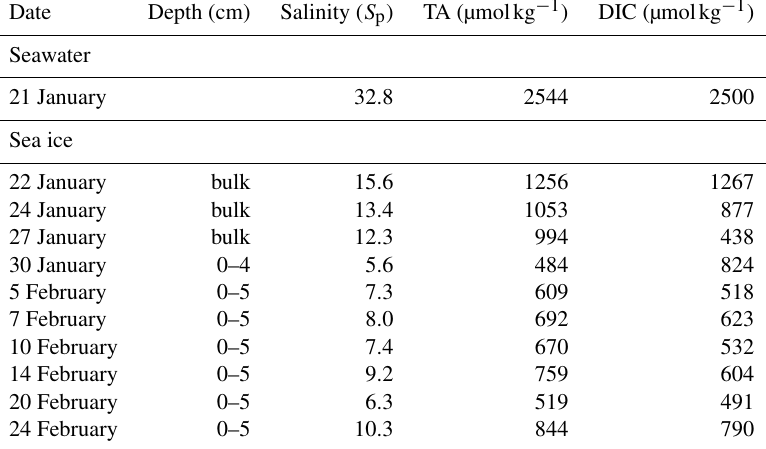
Table 2. Dissolved inorganic carbon (DIC) and total alkalinity (TA) of the seawater and sea ice during Experiment